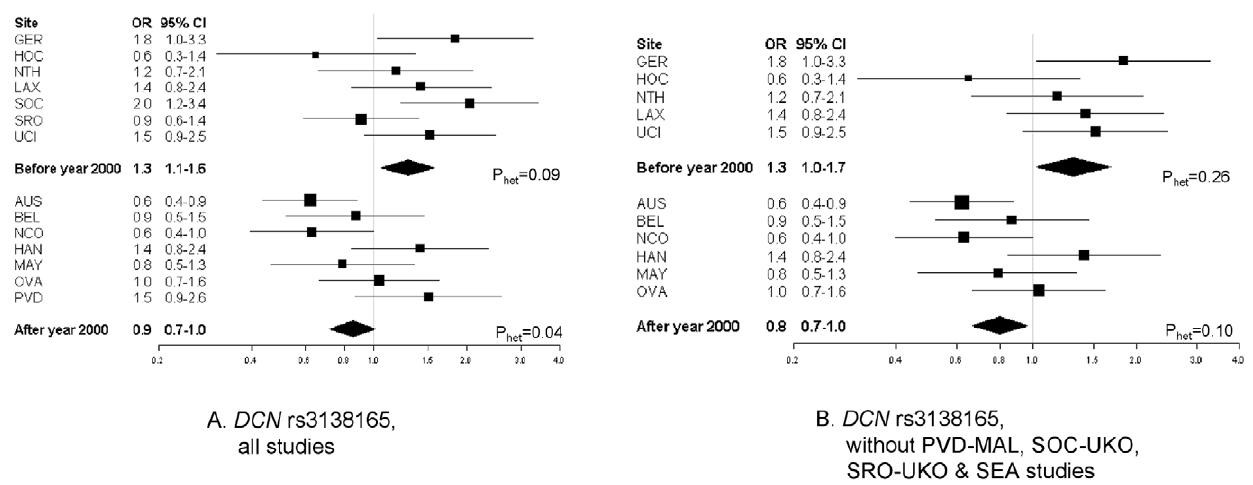
Figure 2. Sensitivity analysis for DCN rs3138165 and serous epithelial ovarian cancer stratified by case recruitment period. Associations represent ORs (95% CI) for individual study (squares) and study-adjusted pooled (diamonds) estimates. Models are ordinal genetic risk models. HAN-HJO and HAN-HMO were combined for presentation. P het refers to P value for heterogeneity in odds ratios among studies.